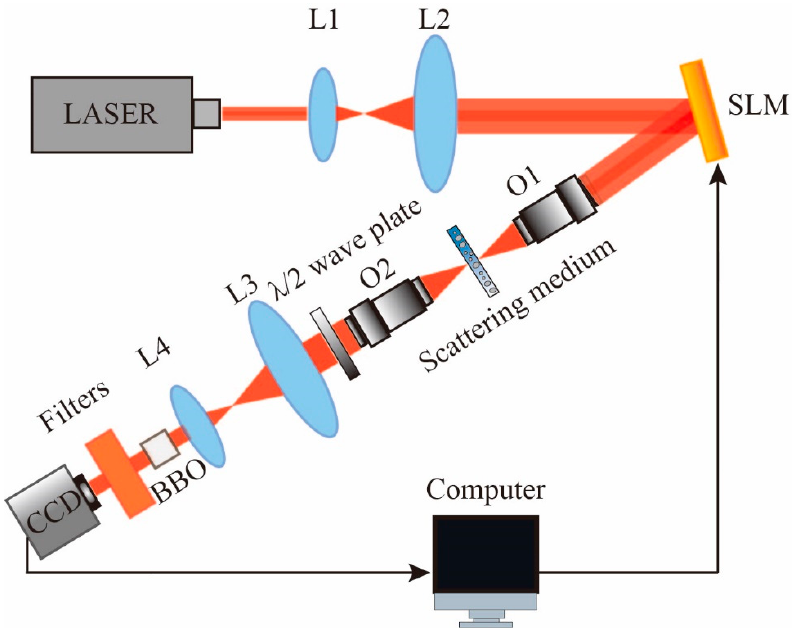
Figure 1. Experimental setup. The focal lengths of lenses L1, L2, L3, and L4 are 50 mm, 100 mm, 50 mm, and 20 mm, respectively. Numerical apertures of the objective lenses (O1 and O2) are 0.25 and 0.4, respectively. BBO: type I, 10 × 10 × 0.2 mm, θ = 29.2°, φ = 0°.